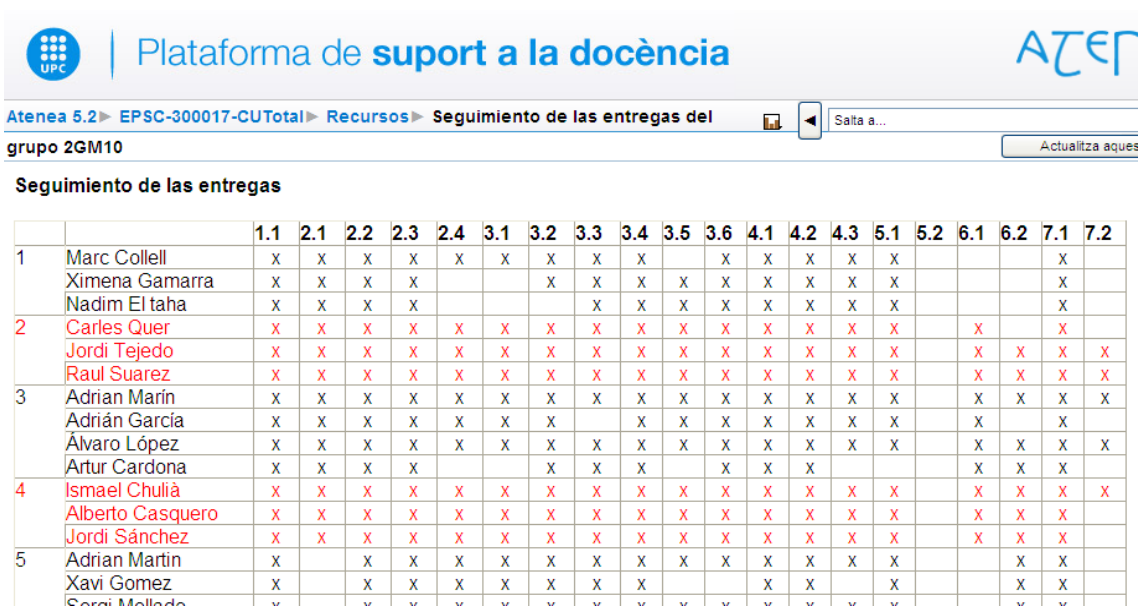
Fig. 2: Webpage in which the fulfillment of student’s deliveries can be